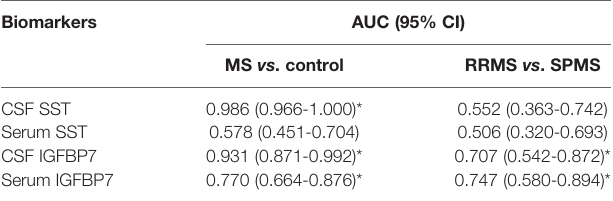
TABLE 2 | Diagnostic value of SST and IGFBP7 in